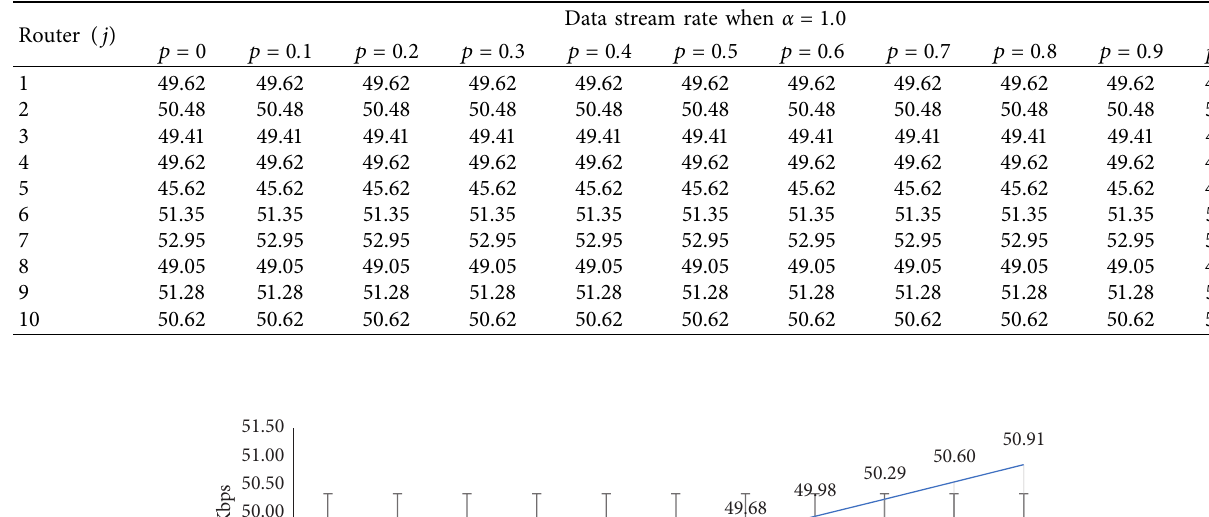
Table 9: Data stream rate for different values of p and α � 1 . 0.